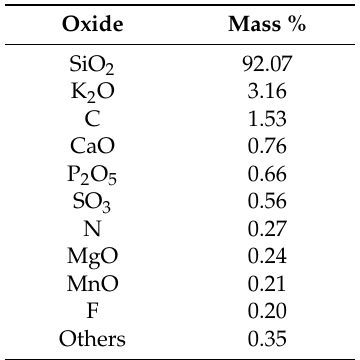
Table 1. Oxide composition of the rice husk ash (RHA).